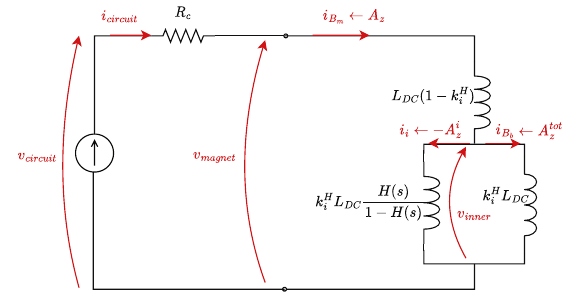
Figure 4: Circuit model seen from a power converter of a lossy superconducting magnet: most general inner conducting